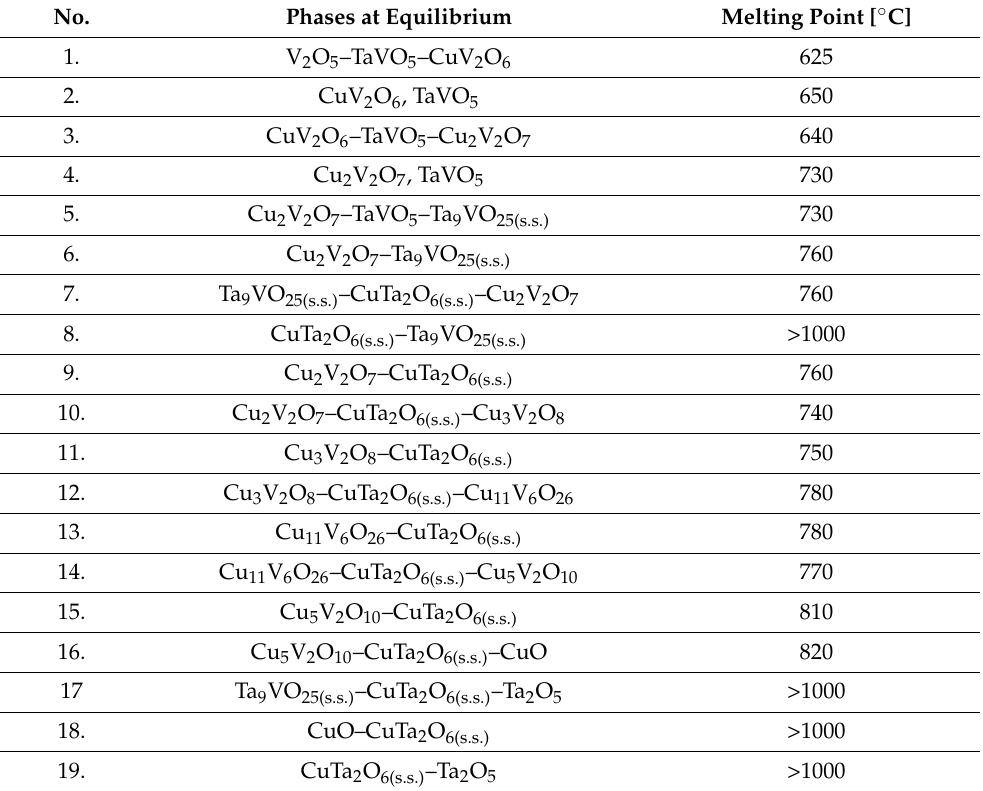
Table 5. Melting point of the samples in equilibrium state.